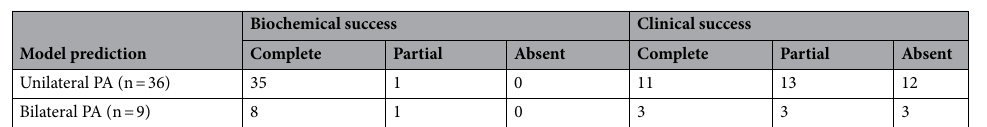
Table 3. Surgical outcomes per prediction of feature-selected random forest in 45 patients with unilateral subtype of primary aldosteronism undergoing adrenalectomy. PA indicates primary aldosteronism.